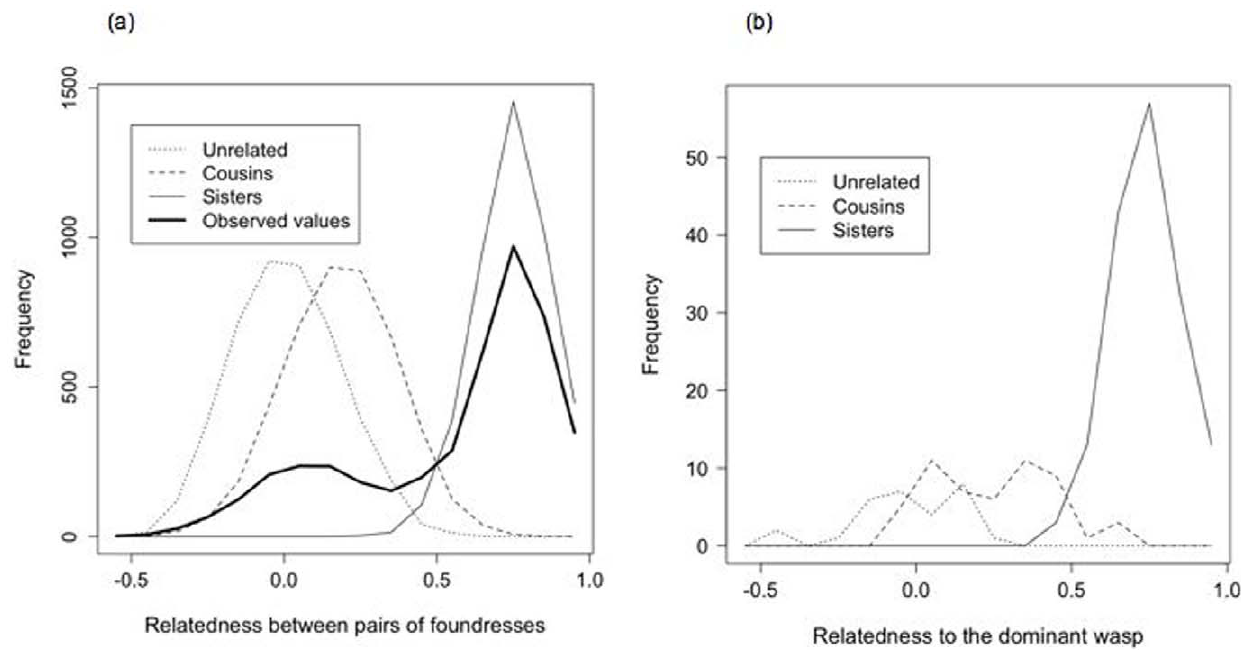
Figure 2. Relatedness in the study population and sample. a) Distribution of pairwise nest-mate relatedness across whole population, based on a sample of 4396 cofoundress pair (broad line). Further lines represent pairwise relatedness from simulated populations comprising 4396 pairs of sisters, cousins, and unrelated wasps b) Distribution of relatedness to the dominant wasp for subordinates classed as sisters of the dominant, cousins of the dominant, and non-relatives, on nests used for behavioural observations. Categories overlap because allocations are based on pairwise likelihoods, which depend on the population allele frequencies, and not absolute cut-off values. For example, an individual that is related to the dominant by less than 0.1 might be found to be more likely a cousin than unrelated, if the particular alleles that the two individuals do share are rare in the population.